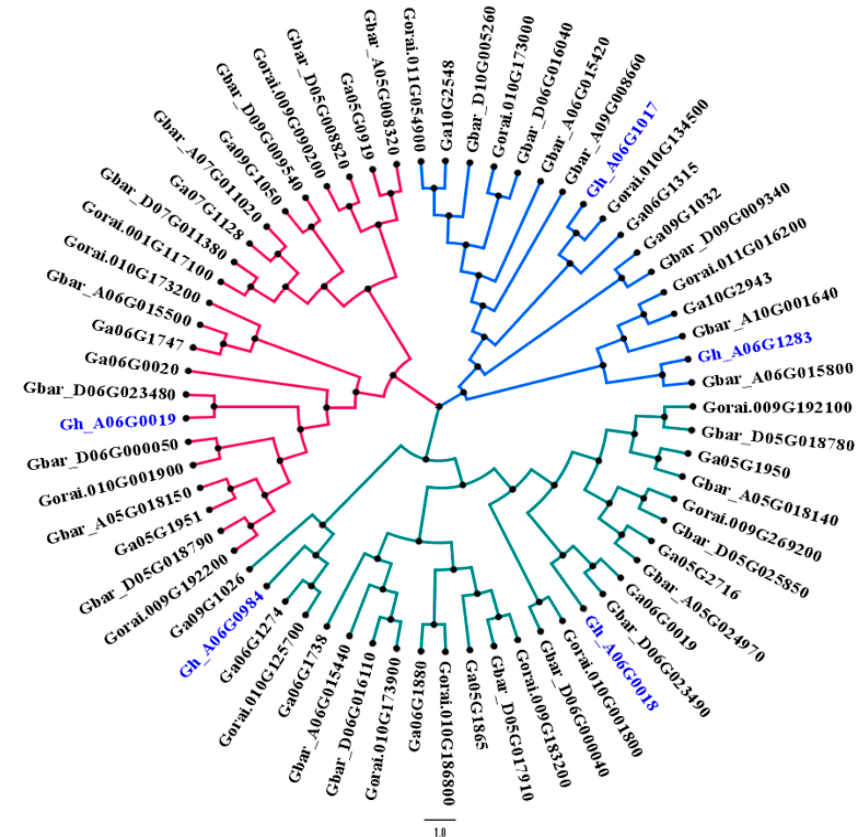
Figure 3. Phylogenetic relationship between candidate genes of G. hirsutum with G. raimondii, G. arboreum, and G. barbadense. The color scheme of the phylogenetic tree represents different clades. Gene IDs in the blue color are putative genes found in this study.